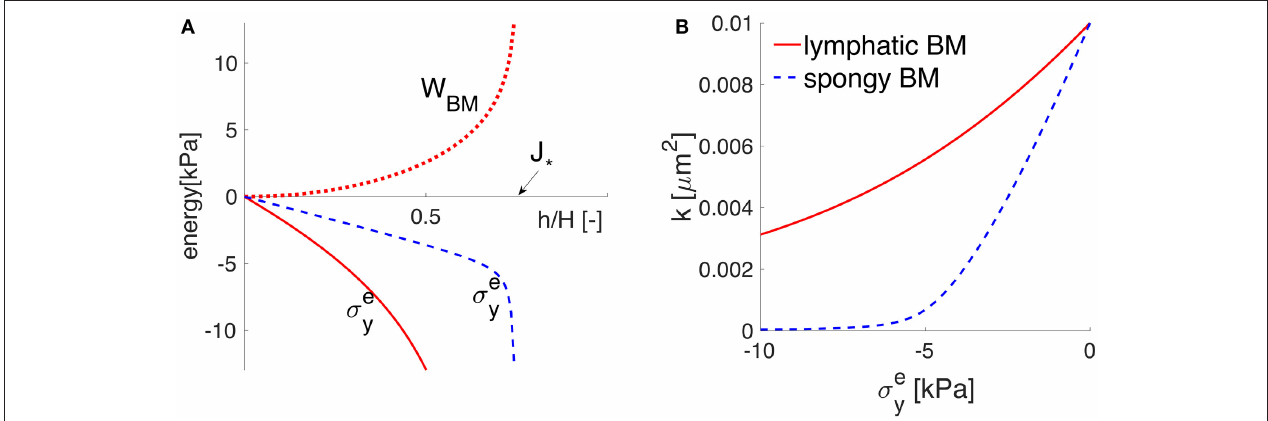
FIGURE 3 | The elastic response of the poroelastic BM. The potential behavior of an idealized “spongy” material is sketched in dotted blue line, while that of the “lymphatic” BM considered throughout this study is plotted in solid red line. (A) The strain energy function W BM = W BM ( h / H ) in the upper (positive) part and the principal Cauchy stress σ y e = σ y e ( h / H ) in the lower (negative) part, as functions of the stretch h / H . The values of h / H (smaller than one) show that the BM thickness is compressed by the normal elastic stress σ y e until reaching the physically-valid lower limit J ∗ . (B) the stress-permeability relationship, according to which the BM permeability k decreases non-linearly with an increases in the compressive normal stress σ y e .